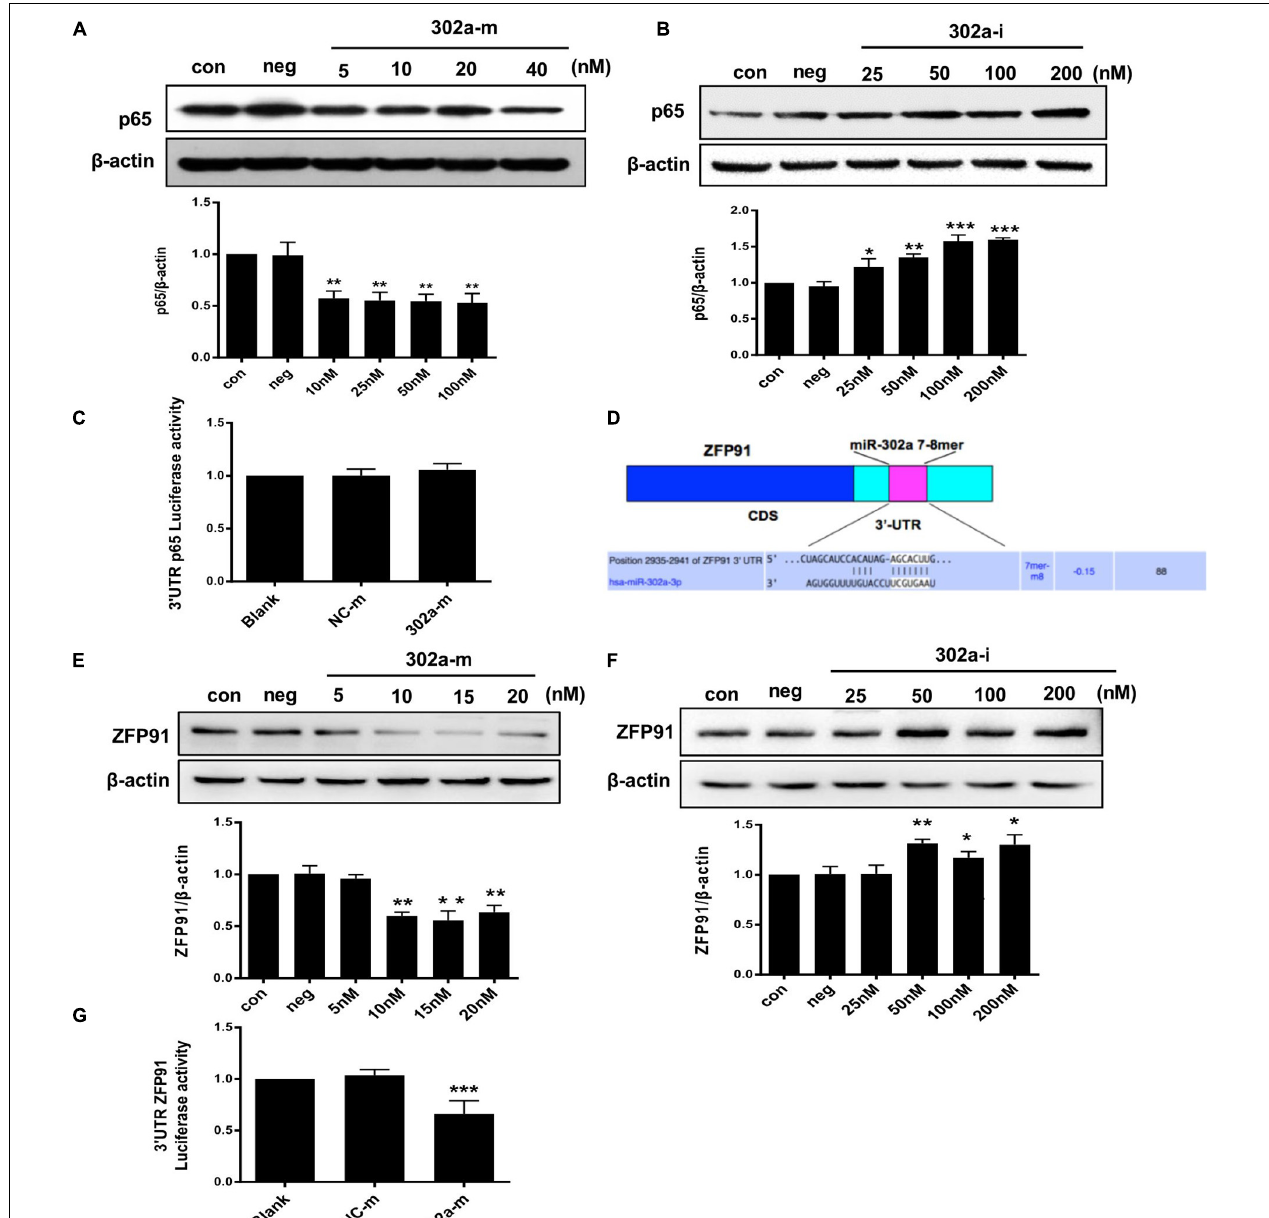
FIGURE 7 | MiR-302a regulates the expression of p65 by targeting ZFP91. (A) P65 level in HUVECs transfected with miR-302a mimics (302a-m), ** p < 0.01 vs. mimics negative control mimics (NC-m), n = 5. (B) P65 level in HUVECs transfected miR-302a inhibitor (302a-i), * p < 0.05; ** p < 0.01; *** p < 0.001 vs. inhibitor negative control (NC-i), n = 6. (C) The luciferase activity of p65-3 (cid:48) UTR in HEK 293T cells after transfected with miR-302a mimics, n = 5. (D) Possible binding sequence of ZFP91 with miR-302a predicted by TargetScan software. (E) ZFP91 expression in HUVECs transfected with miR-302a mimics, ** p < 0.01 vs. NC-m, n = 5. (F) ZFP91 expression in HUVECs transfected with miR-302a inhibitor, * p < 0.05; ** p < 0.01 vs. NC-i, n = 5. (G) The luciferase activity of Luc-ZFP91-3 (cid:48) UTR in HEK 293T cells transfected with miR-302a mimics. *** p < 0.001 vs. NC-m, n =